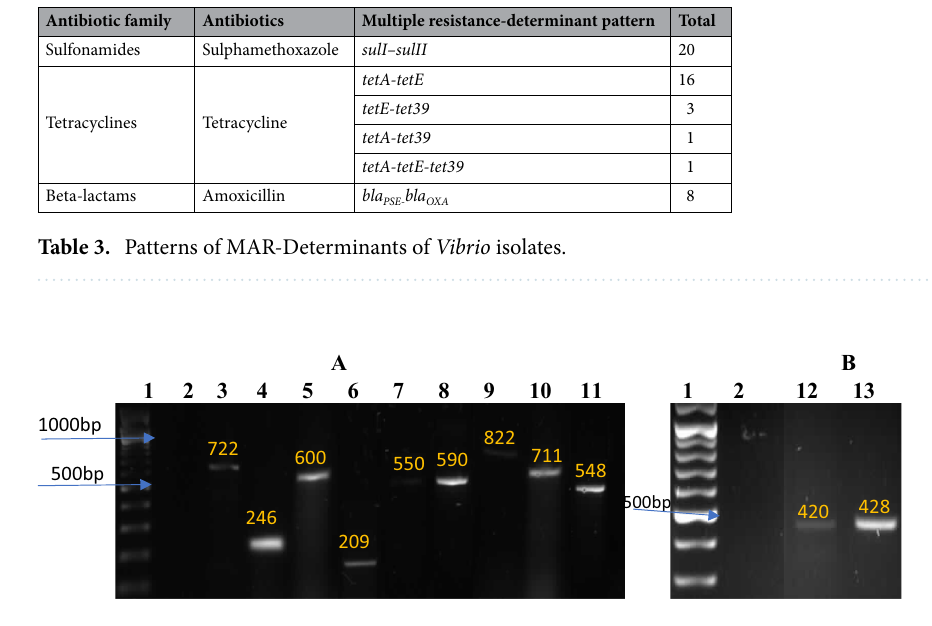
Figure 4. ( A , B ) Gel electrophoresis characteristic of antibiotics resistance genes in Vibrio Isolates. Lanes 1: Molecular marker (100 bp), lane 2: −ve control; lane 3: sulII (722 bp); lane 4: tetE (246 bp); lane 5: